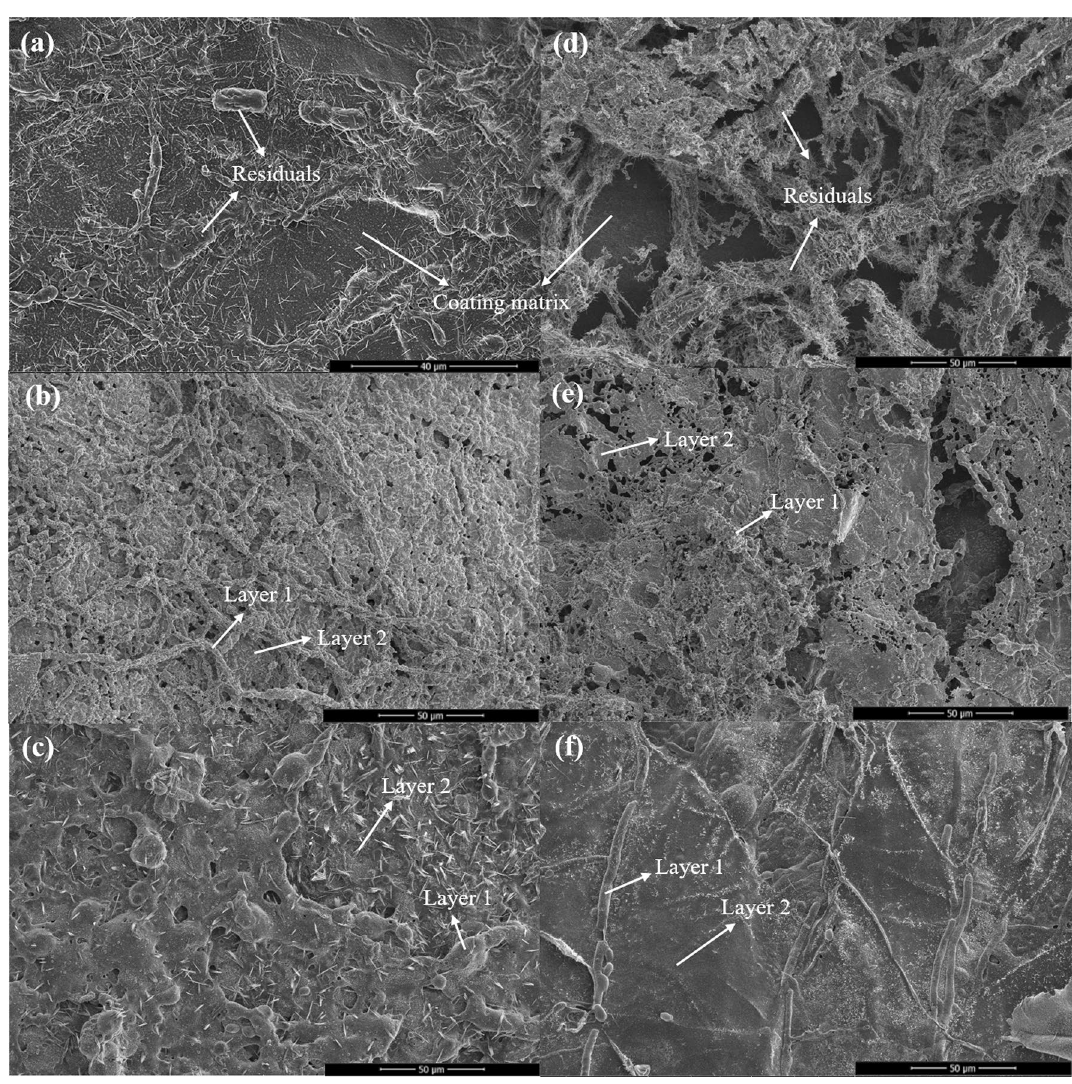
Figure 14. Micrographs of residual chars from ( a ) FSi0, ( b ) FSi1, ( c ) FSi2, ( d ) FSi0-P, ( e ) FSi1-P, and ( f )